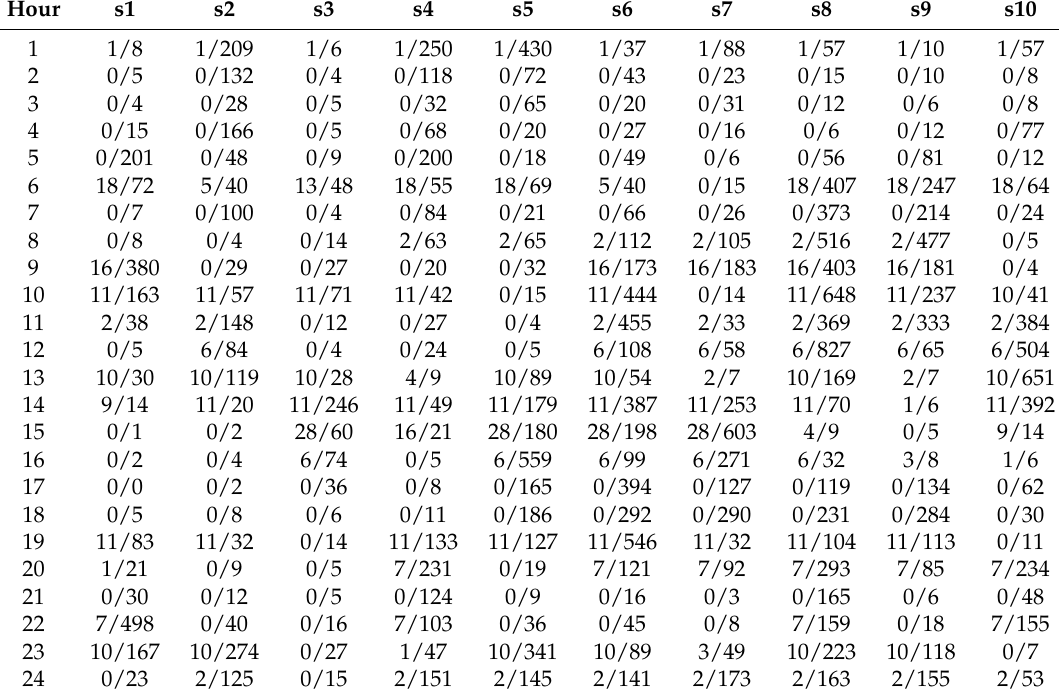
Table 4. Volume of down reserve activation provided by the battery per scenario as a portion of the overall activated reserve (rounded to an integer unless close to zero), in